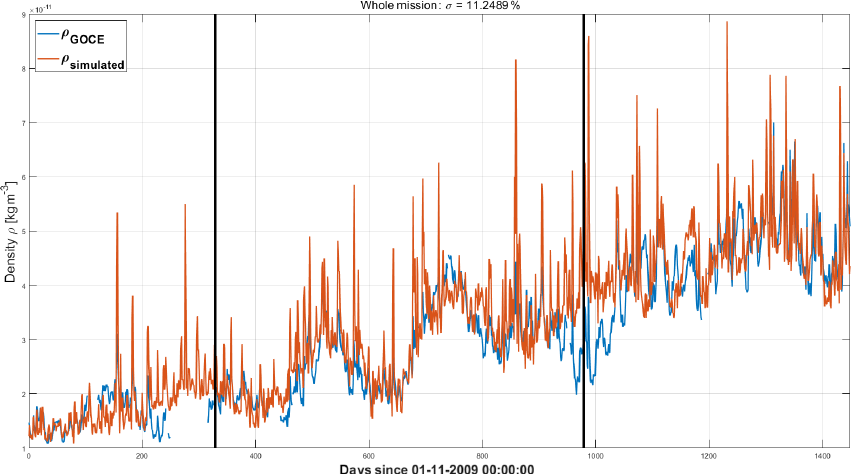
Figure 12. Effect of orbit lowering on the third period of high solar activity, from 1 August 2012. Density data (blue line), as shown in Fig. 10, have been de-trended to subtract the contribution due to orbit lowering. Red line shows synthesized thermospheric-density values from the optimal combination of Ap, Mg II and F10.7. Whole